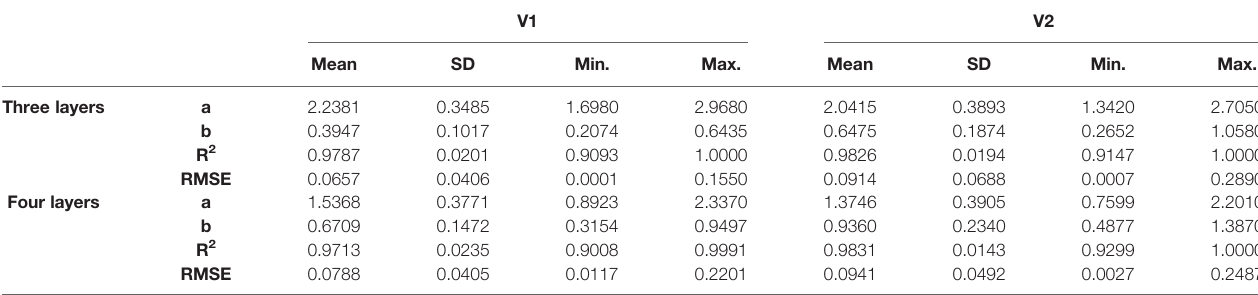
TABLE 1 | Basic statistics of the parameters of the vertical distribution of the leaf nitrogen content model. V1 V2 Mean SD Min. Max. Mean SD Min. Max.